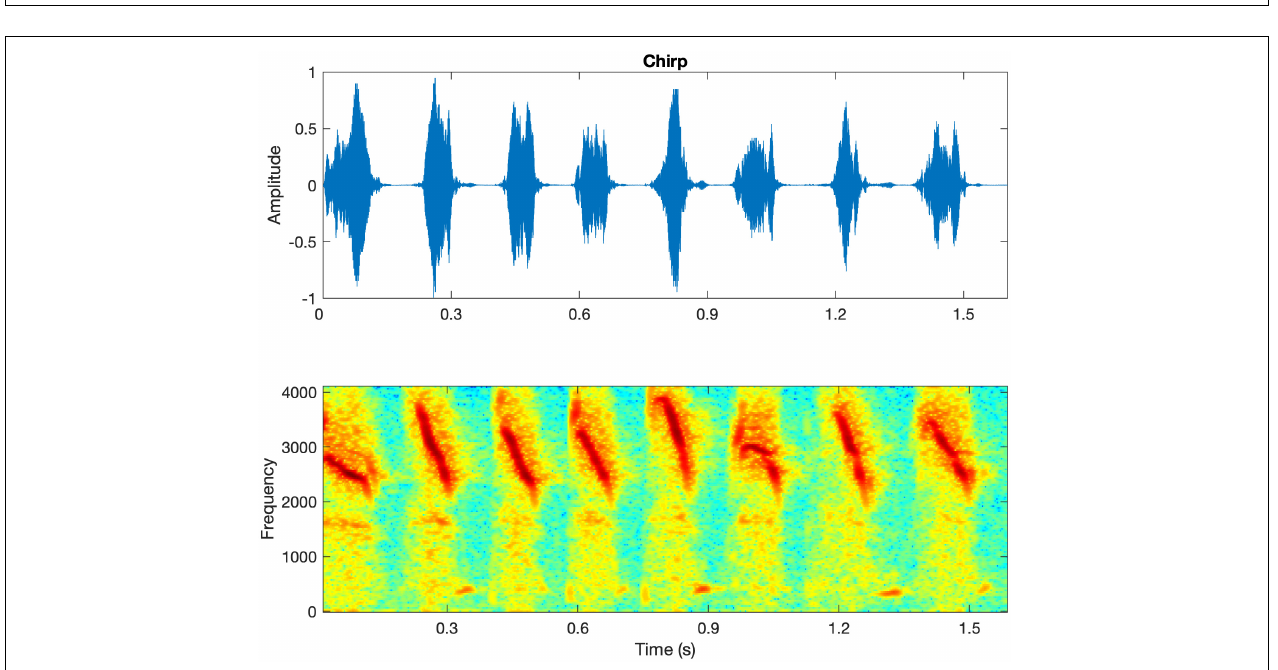
FIGURE 1 | Unaided pure-tone thresholds of left and right ears in the 29 subjects. The thin gray lines represent individual thresholds and the thick black line represents the group mean threshold ( n = 29). The shaded area represents ± 1 S.D. of the mean.